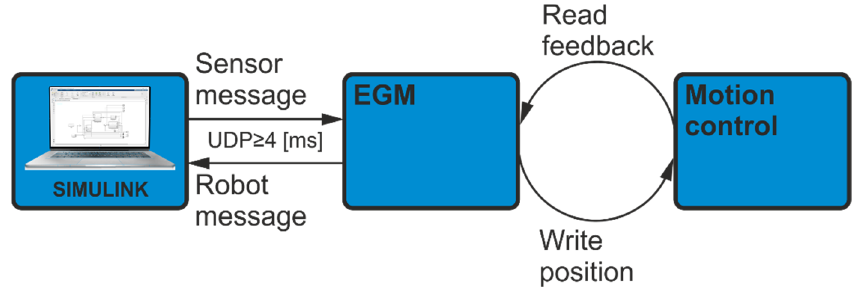
Figure 2. Communication diagram.